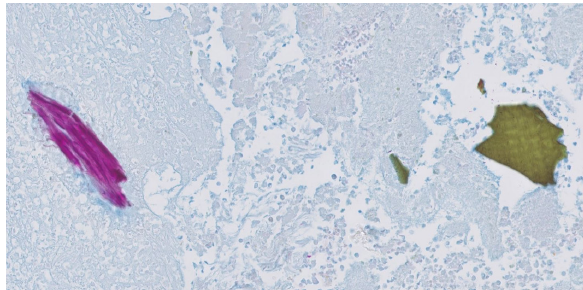
Figure 8: High power image of Kayexalate (left) and seve- lamer (right) crystals with differential staining patterns (Kinyoun, 20×